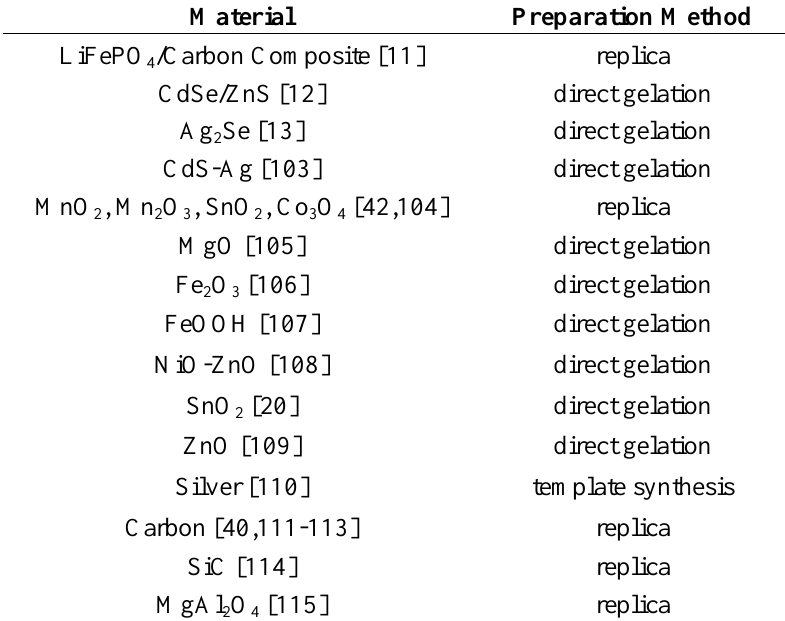
Table 1. Overview of monolithic mesoporous materials synthesized using different